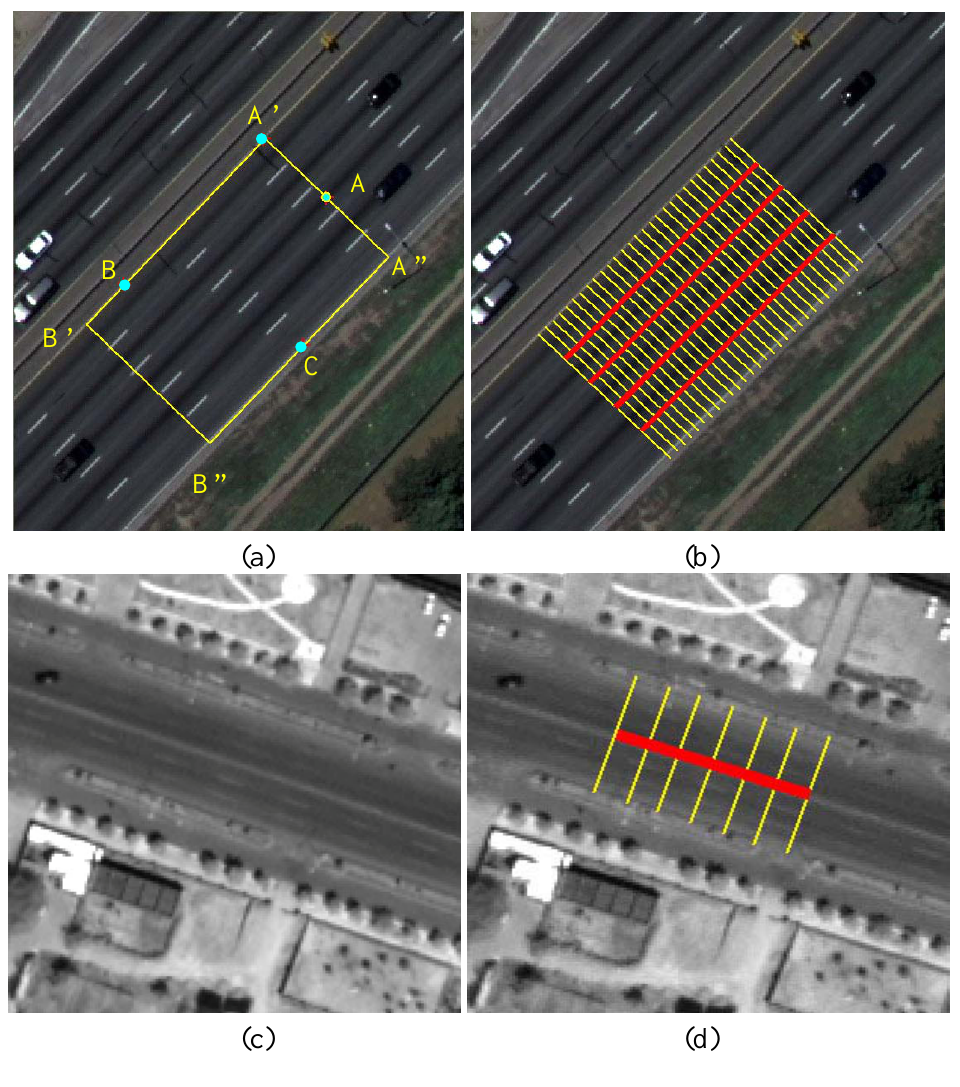
Figure 1. Construction of the interlaced template and detection of the road markings. (a) A subset of color aerial image and the initialization of our road tracker; (b) the interlaced template of the road surface in (a); (c) a subset of a panchromatic satellite image; (d) the interlaced template of the road surface in (c); (e) the profile transformations of the ribbon road in (b) and there are four salient peaks representing the four lane markings on the road surface; (f) the profile transformations of the ribbon road in (d) and there is only one salient peak representing a marking line on the road